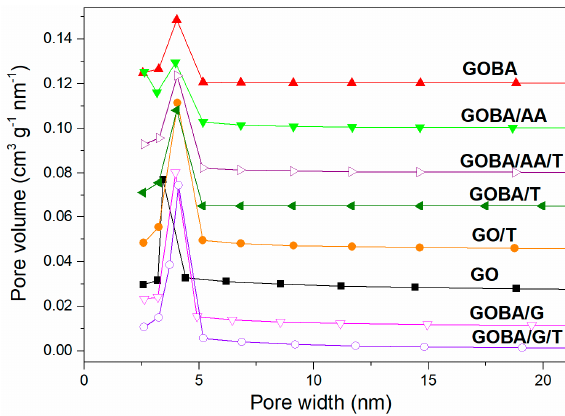
Figure 4. Pore size distribution of GO and rGO samples.